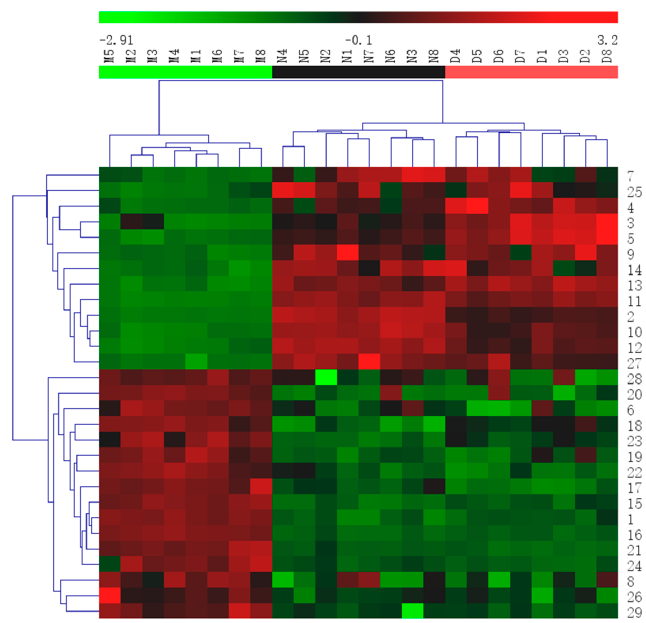
Figure 10. Bi-plot of biomarkers observed in serum (S, green spots) and hippocampus (H, blue spots). Then, a heat map was generated from the biomarkers to effectively visualize and depict the distinction between groups (Figure 11).